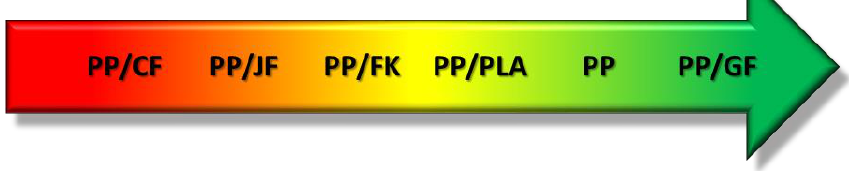
Figure 5. Schematic diagram of recommended material variants for EUR-pallet in terms of water footprint.